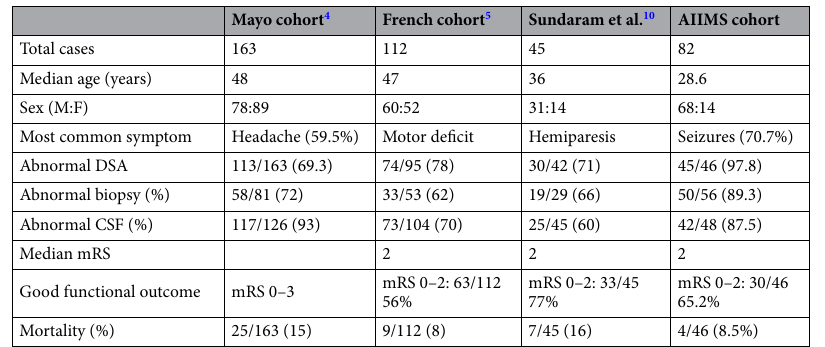
Table 3. Comparison between the largest cohorts of